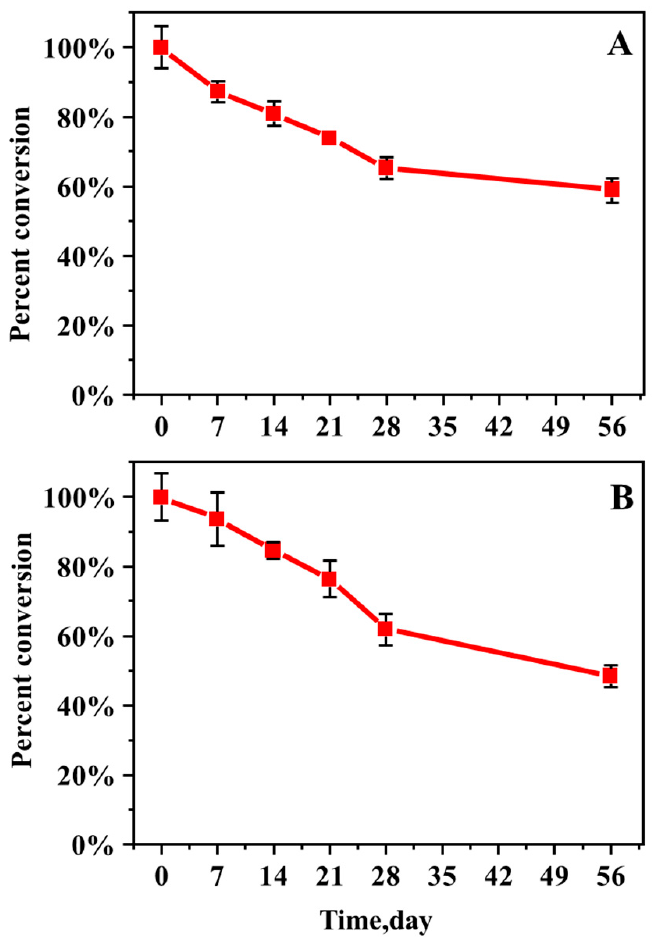
Figure 6. Percentage change in AA I ( A ) and AA II ( B ) from initial soil concentration in the soil where lettuce was grown.